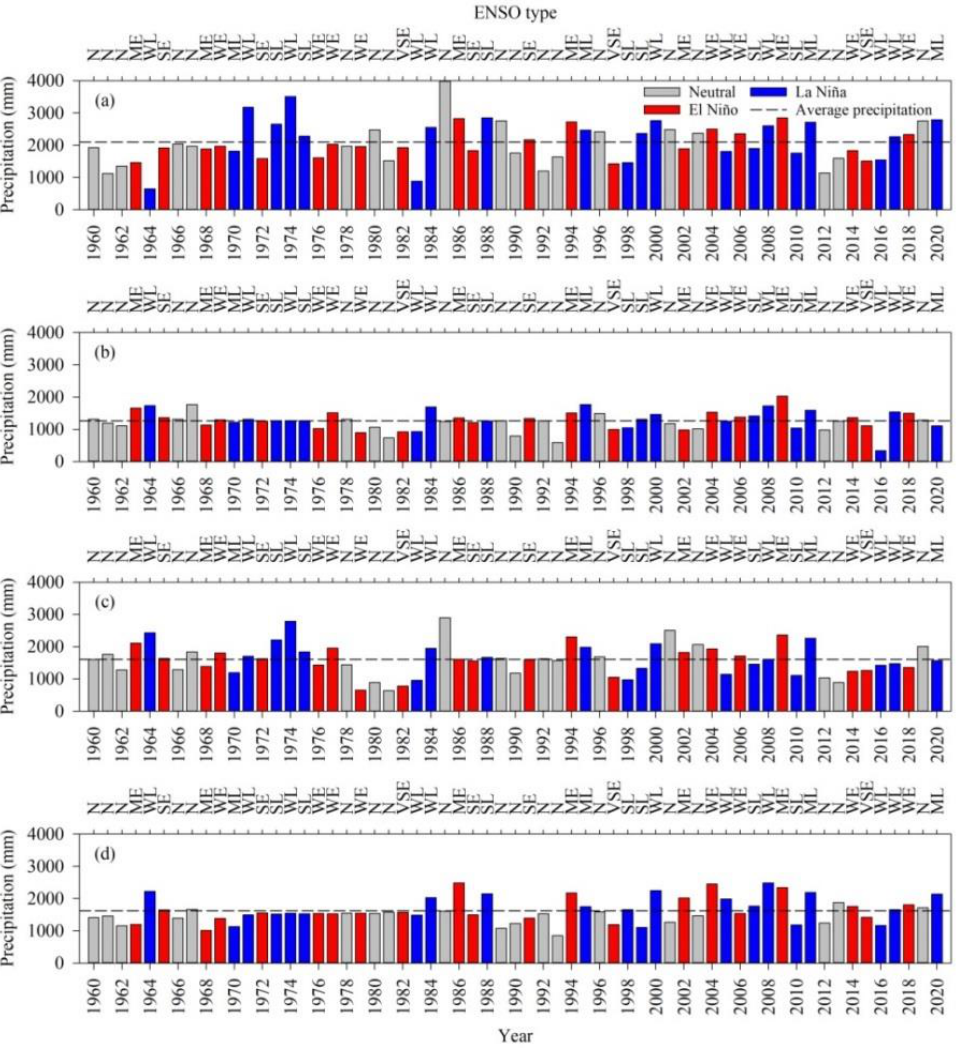
Figure 3. Annual rainfall distribution (mm/year) in the capitals of the NNEB — São Luís ( a ), Teresina ( b ), Fortaleza ( c ), and Natal ( d ). El Niño, La Niña, Neutral, and their intensities based on the Oceanic Niño Index (ONI): N: Neutral, WE: weak El Niño; ME: moderate El Niño; SE: strong El Niño; VSE: very strong El Niño; WL: weak La Niña; ML: moderate La Niña; and SL: strong La Niña. The colors in the bars are Neutral in grey, La Niña in blue, and El Niño in red, and the dashed line represents average rainfall for the period 1960 – 2020.